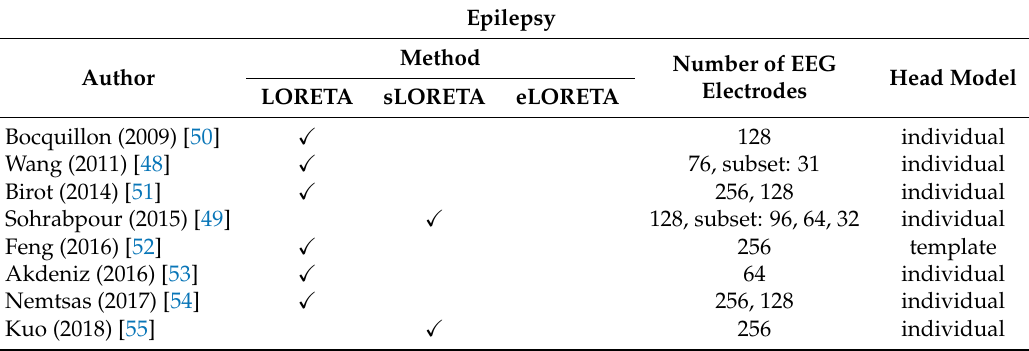
Table 2. Overview of the included papers about